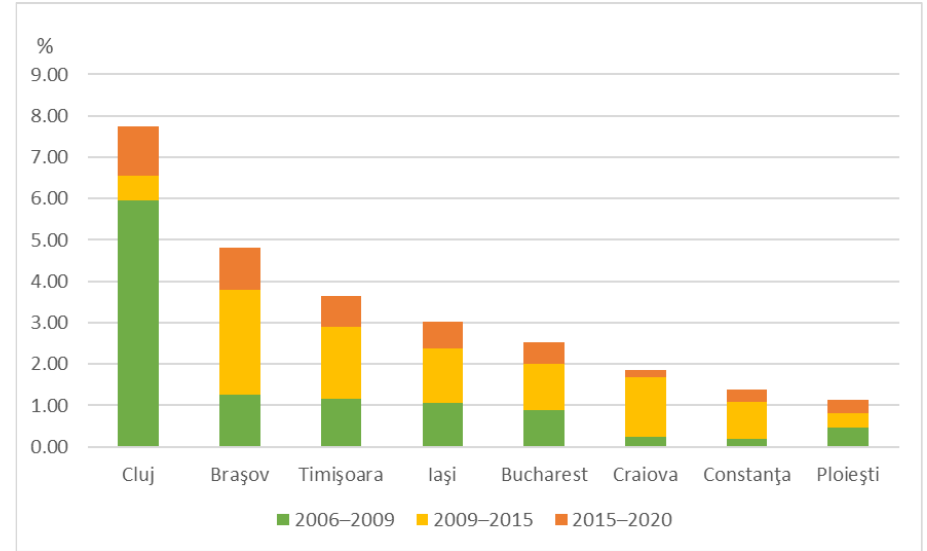
Figure 7. The built-up space increase rate evolution for the three